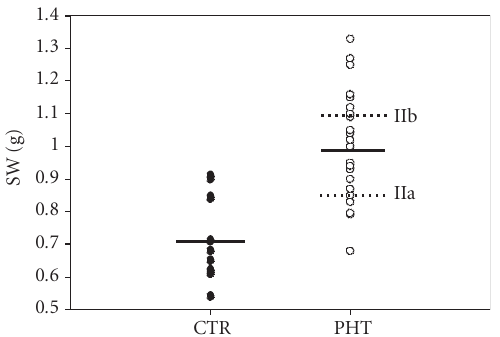
Figure 1. Residual plot showing the distribution of spleen weights in all control and TSLP rats. The solid lines represent the mean values for the overall group. The broken lines repre- sent the mean value for the TSLP rats with lower spleen weights (IIa) and the TSLP rats with higher spleen weights